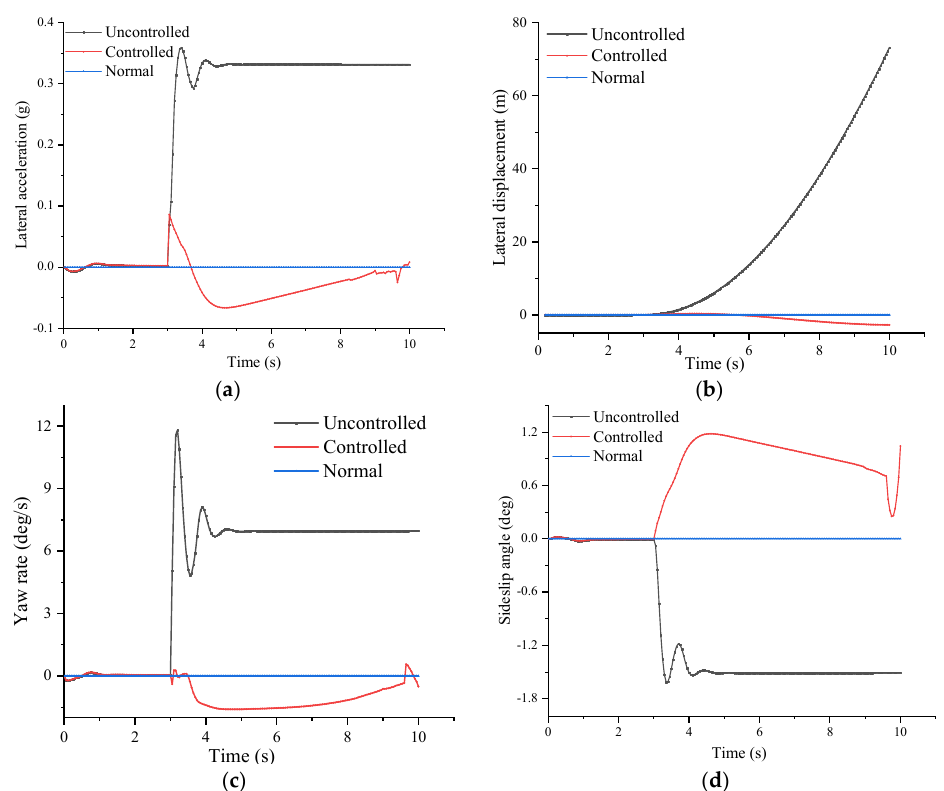
Figure 6. The controlled simulation curve of left front tire blowout: ( a ) lateral acceleration curve; ( b ) lateral displacement curve; ( c ) yaw rate curve; ( d ) sideslip angle curve.